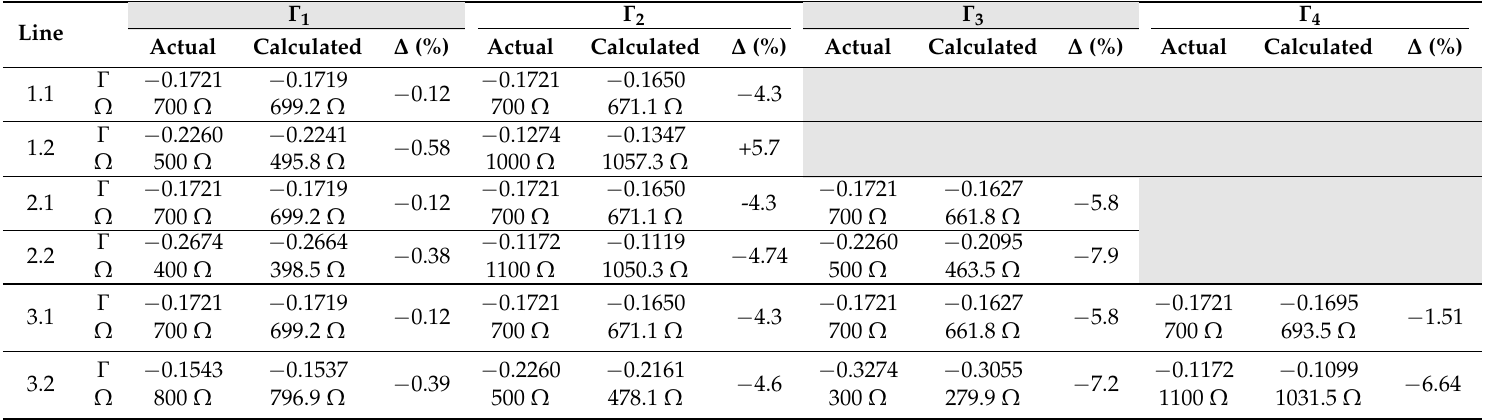
Table 2. Actual versus Calculated (using Layer-Peeling) Reflection Coefficients ( Z c = 292 Ω